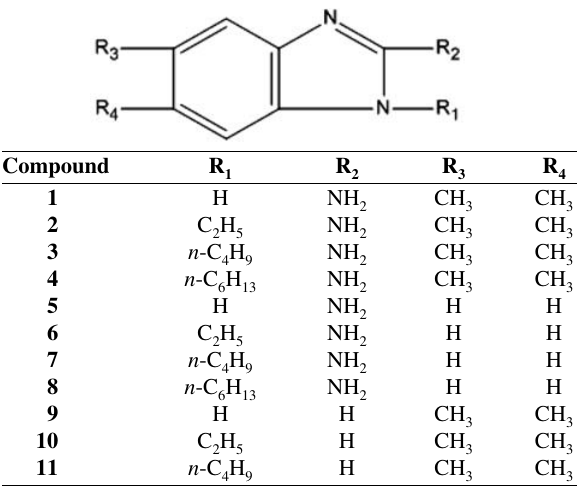
Table 1. Chemical structures of eleven studied benzimidazole deri- vatives.